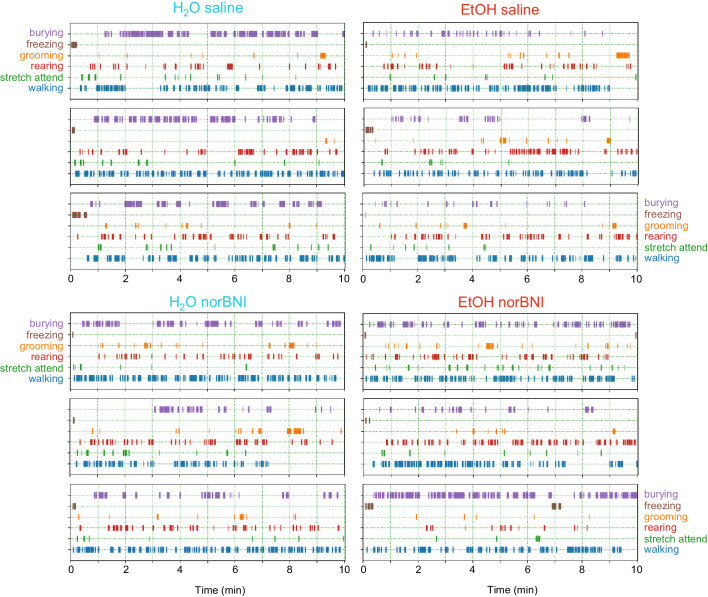
Home cage TMT predator odor ethograms.Stress-related and exploratory behaviors were observed and plotted using BORIS behavioral software: burying (purple), freezing (brown), grooming (orange), rearing (red), stretch-attend (green), and walking (blue). H2O mice are in aqua on the left. EtOH mice are in red on the right. Saline-injected mice are the top plots over the 5 mg/kg norBNI-injected mice on the bottom. Ticks represent time and duration of behaviors during a 10 min test.